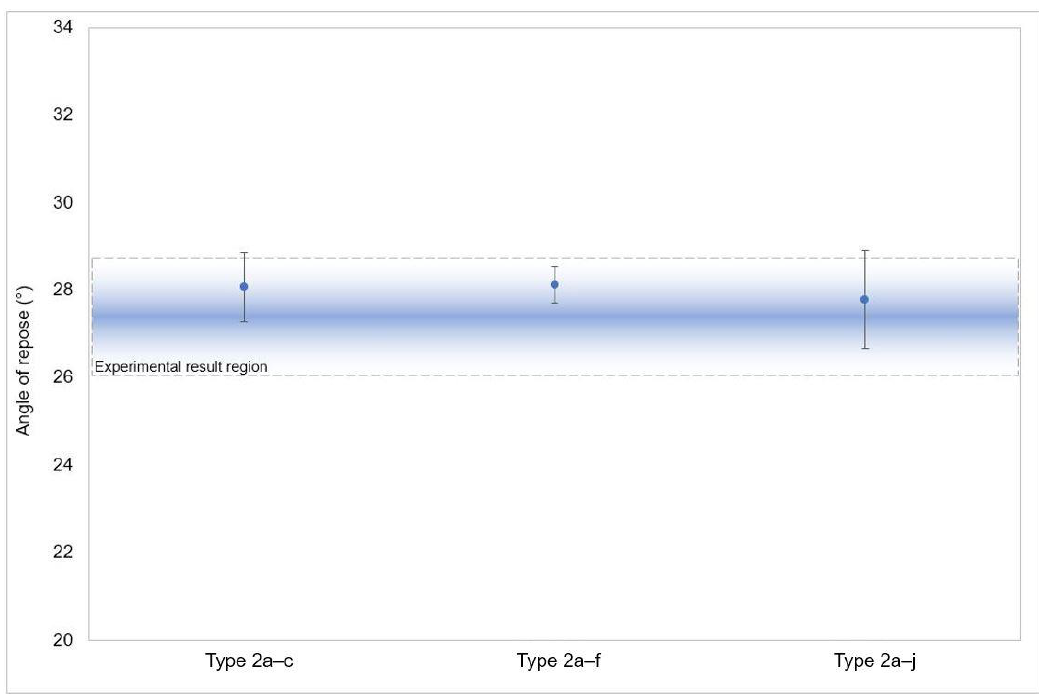
Figure 15. Angle of repose of three (Type 2a – c), six (Type 2a – f), and ten (Type 2a – j) powder mor- phology obtained from SEM images of real particles.